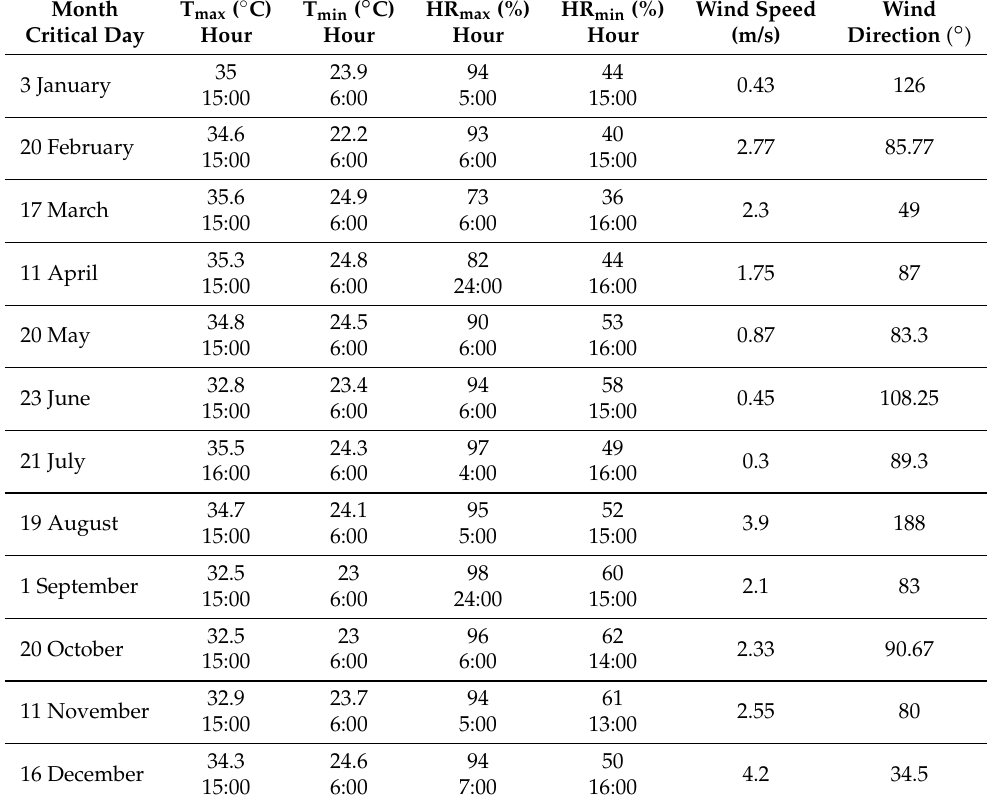
Table 3. Typical meteorological data used for